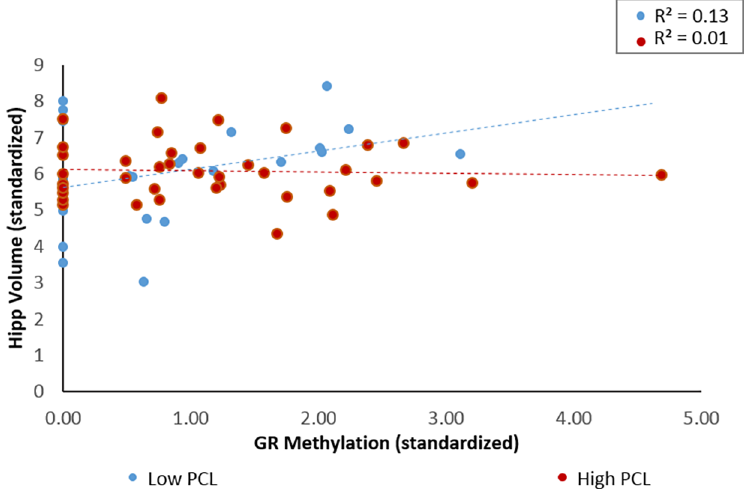
Fig 2. The relationship between GR methylation and hippocampal volumes for participants who are likely to have met diagnostic criteria for PTSD and those who likely do not. In patients who scored above the PCL-C cut-off of 50, no relationship was found, while a positive relationship was found for those who scored